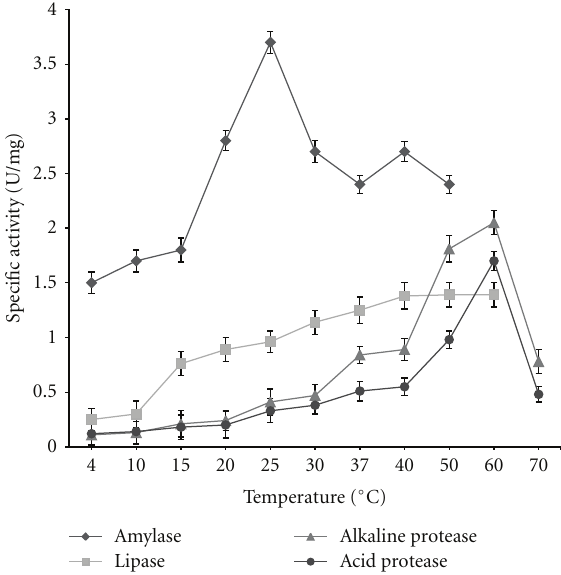
Figure 1: E ff ect of pH on the activity of amylase, lipase, alkaline, and acid proteases in the hepatopancreas of crayfish Cherax albidus juveniles. Gastric juice and intestine gave similar results. Values are reported as means ± SEM. Assays were performed on three samples in duplicate.